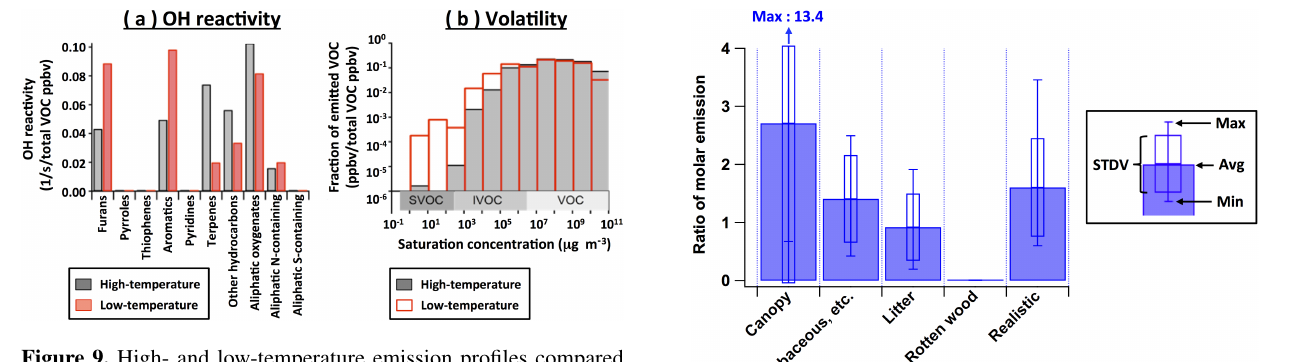
Figure 9. High- and low-temperature emission profiles compared by (a) OH reactivity and (b) volatility, described by saturation con- centration (µgm − 3 ) .